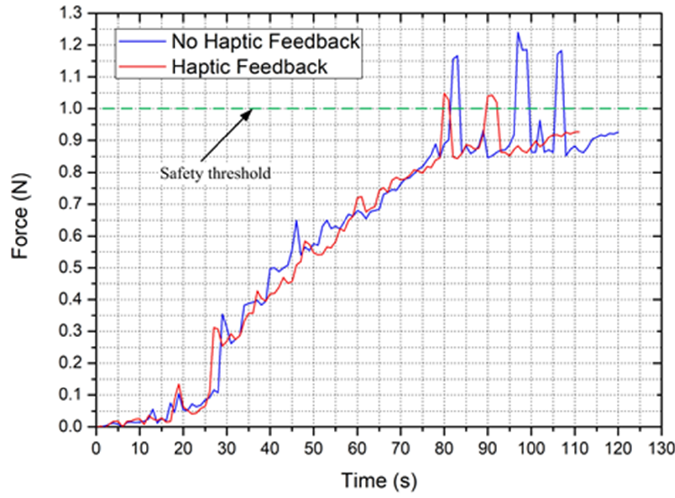
Figure 19. Experimental results of collision detection performance for the presented system.